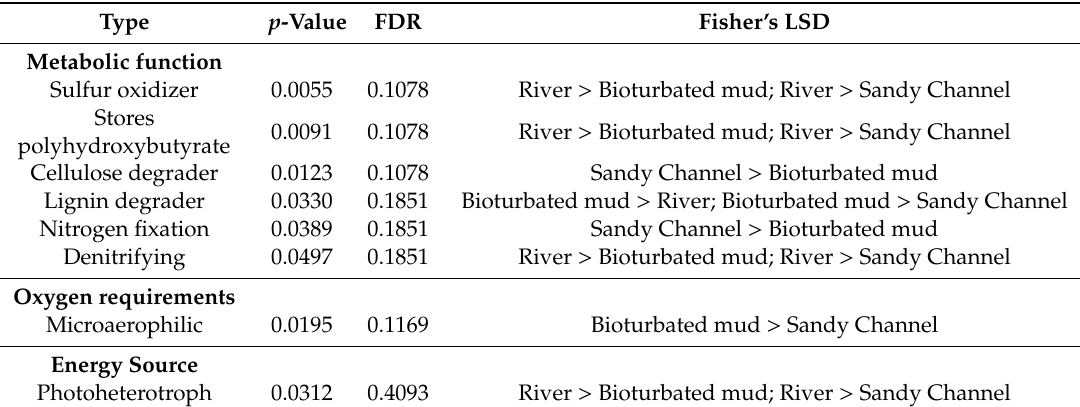
Table 7. Summary of predicted phenotypic classification based on habitat bacterial 16S sequencings data from Moreton Bay marine sediment using one-way ANOVA